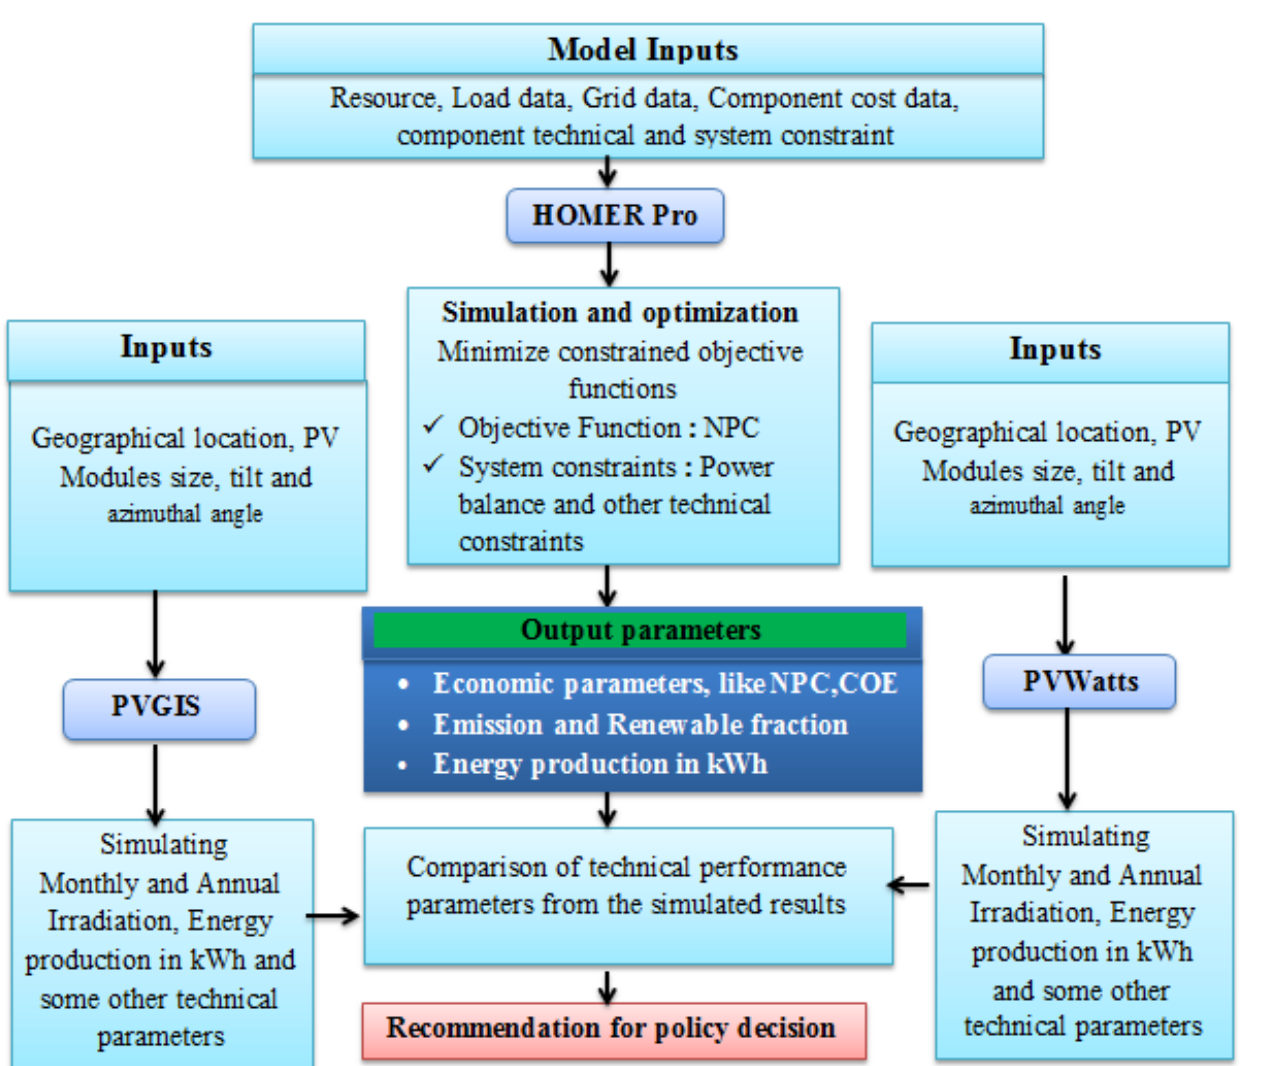
Figure 3. Schematic designation of the tools and methodological steps used in the study.